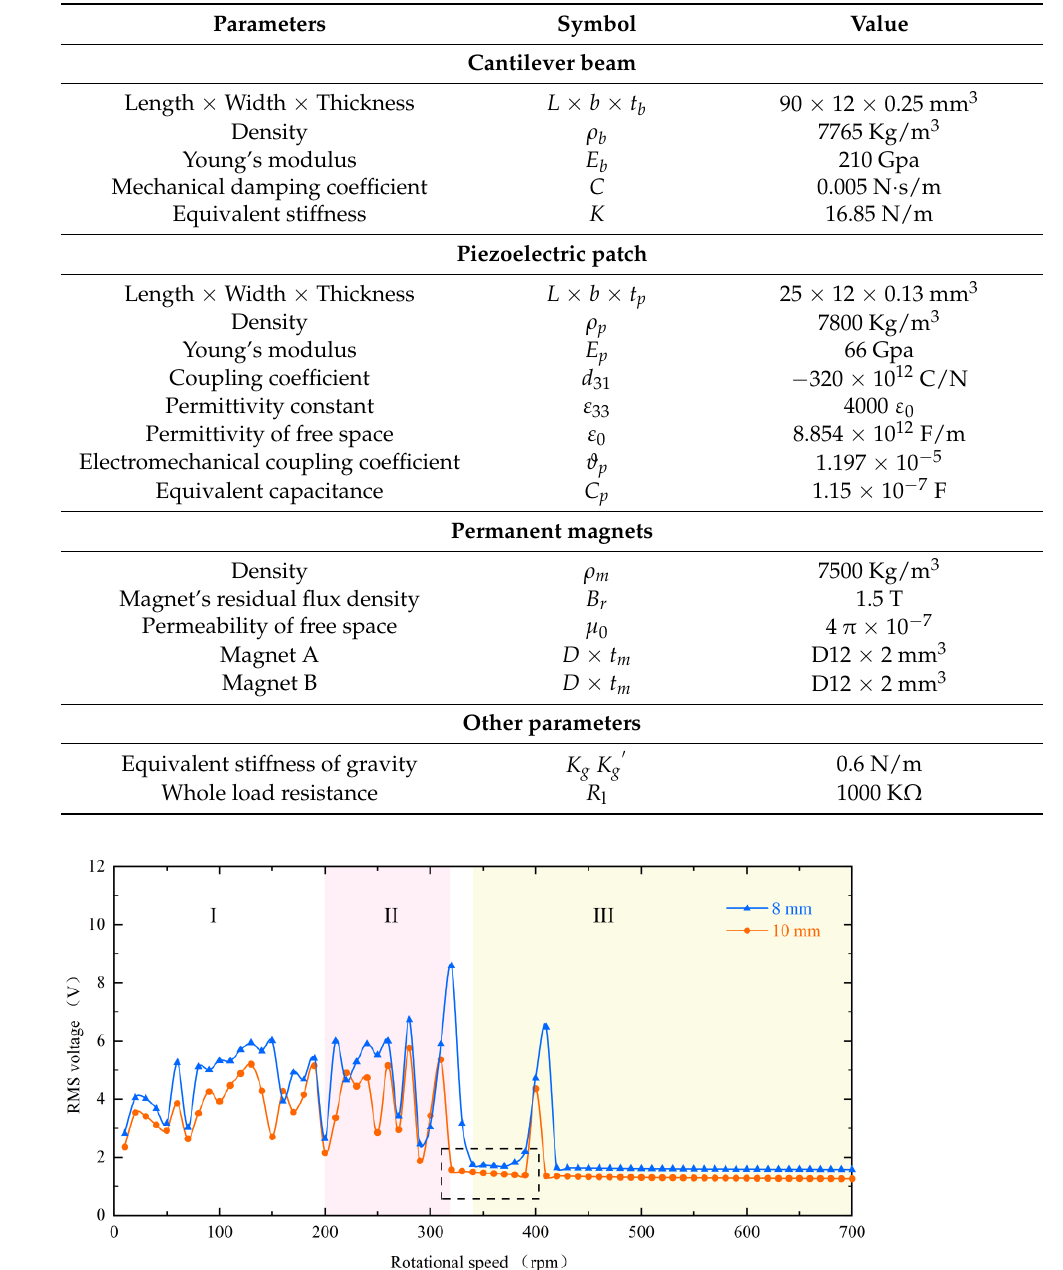
Figure 12. Simulation results of RMS voltage for the inverse beam at magnet spacing of 8 mm (blue line) and 10 mm (red line).